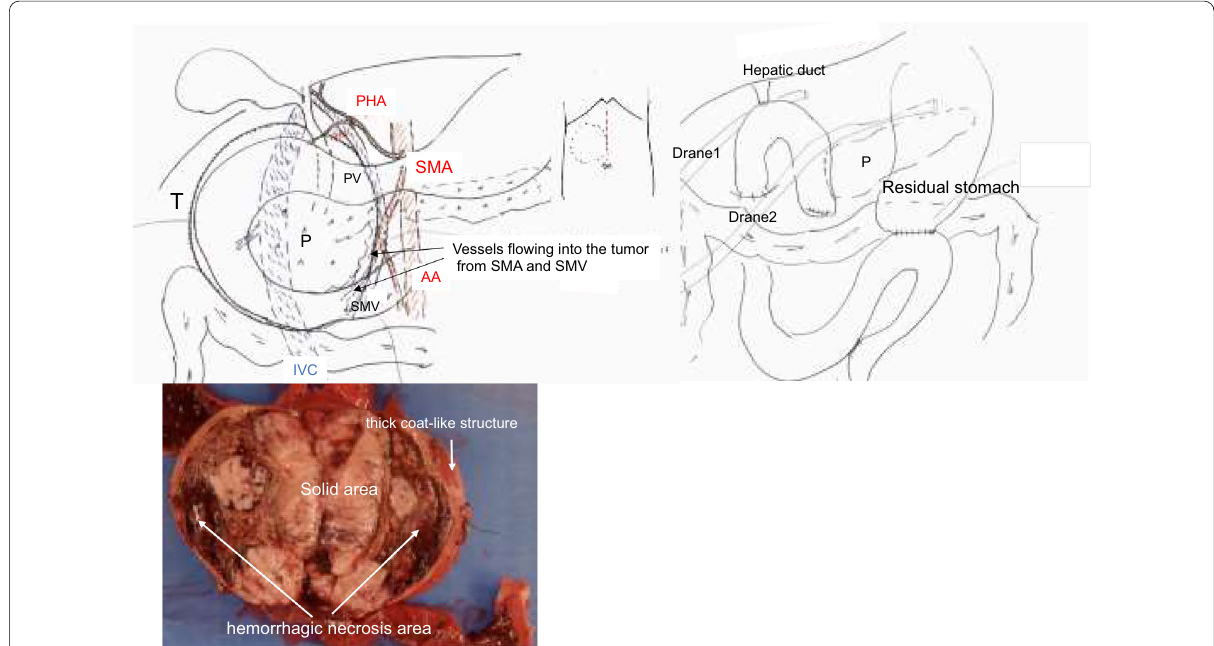
Fig. 3 Surgical findings and resection specimen sections. The abdomen is opened through a midline incision on the upper abdomen. The tumor (T) is located on the dorsal side of the pancreatic (P) head, which is ventrally compressed and thinned. The superior mesenteric vein (SMV), extrahepatic portal vein (PV), and SMA are highly adherent to the tumor but can be dissected while ligating the arteriovenous branches to the tumor. Reconstruction consists of anastomosis of the upper intestine, pancreas, bile duct, and stomach. Braun anastomosis is performed. Drains are placed dorsal (drain 1) and ventral (drain 2) to the bile duct jejunal anastomosis and pancreatic jejunal anastomosis, respectively. Tumor section: The tumor is covered with a thick coat-like structure, and the interior is a mixture of substantial and hemorrhagic necrotic areas. IVC inferior vena